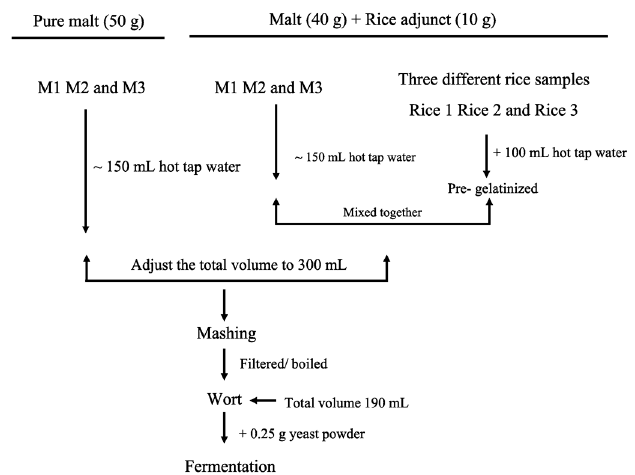
Figure 4. Design of the mashing experiments with pure malts and with malts plus rice adjuncts. Each mashing experiment was conducted in